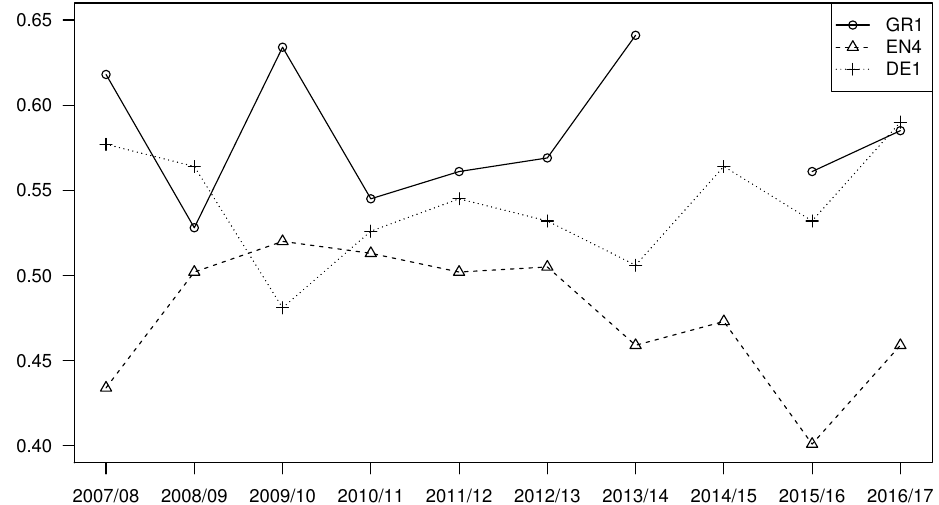
Figure 1. Evolution of ˆ p 1 for DE 1 , EN 4 , and GR 1